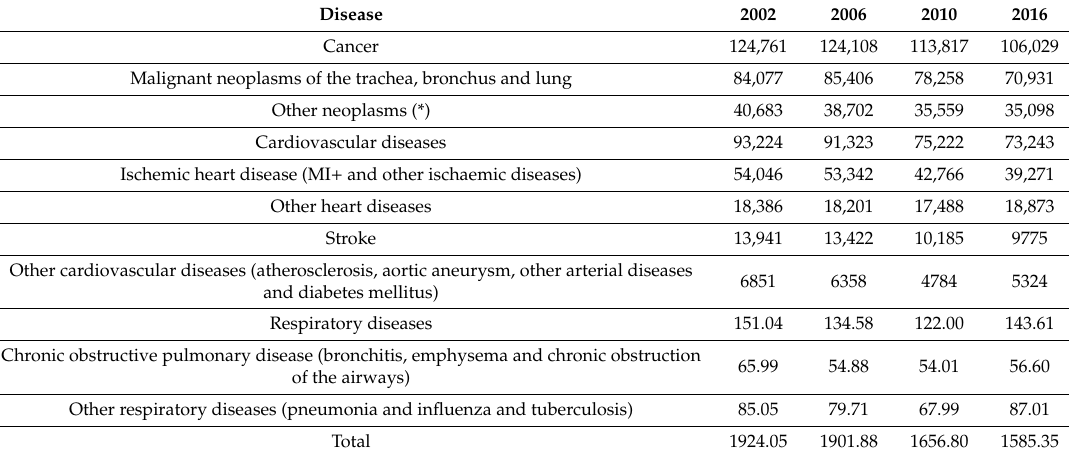
Table A4. Labour losses (discount rate 6%; annual production rate 0%) (millions of euros). Disease